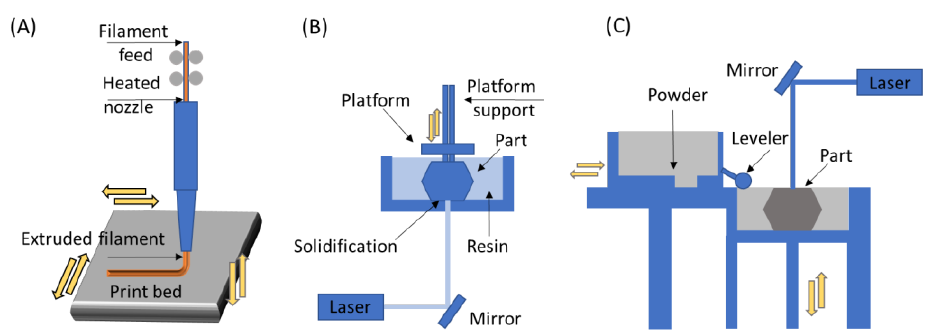
Figure 12. Representation of different 3D printing techniques: ( A ) fused deposition modeling, ( B ) stereolithography, and ( C ) selective laser sintering (adapted from [183]).